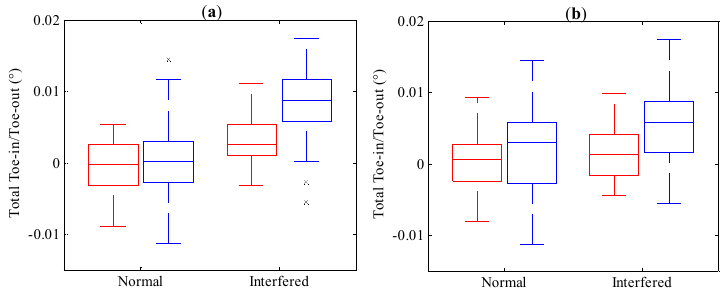
Figure 18. Boxplots of ( a ) front and ( b ) rear toe-in/toe-out values for the proposed (red boxes) and built-in (blue boxes) techniques. Regarding normal and interfered periods.